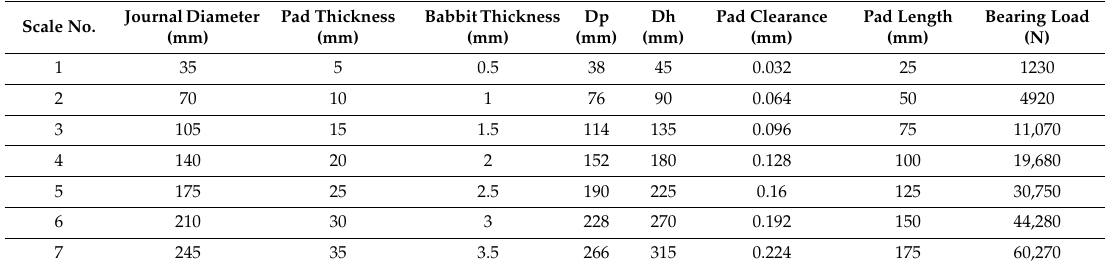
Table 3. Bearing configurations with the same Sommerfeld number.